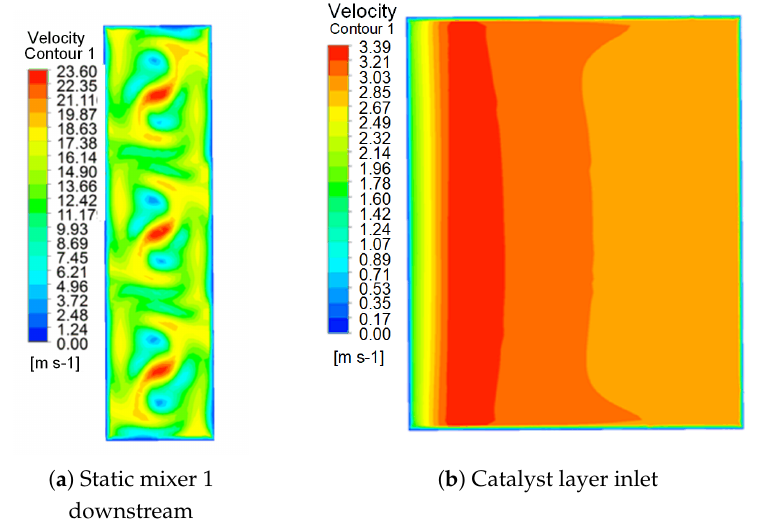
Figure 7. Velocity field with static mixer 1. ( a ): Velocity distribution diagram of downstream section of static mixer. ( b ): Velocity distribution diagram of section in front of the catalyst